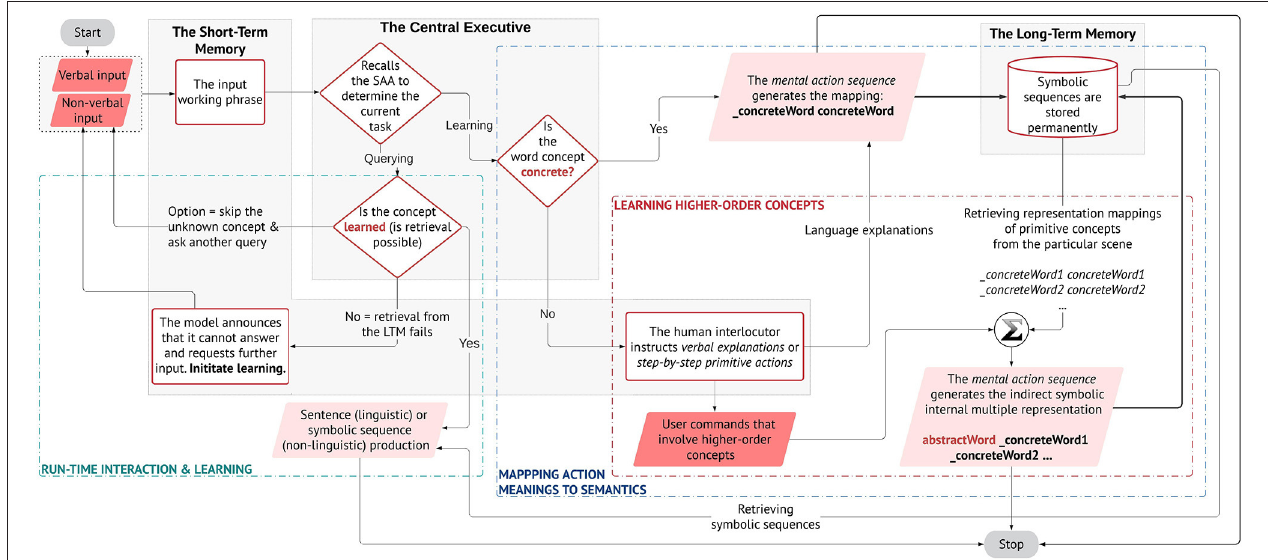
FIGURE 3 | The proposed learning methodology of meanings and language constructions. The central executive (CE), the long-term memory (LTM), and the short-term memory (STM) of the architecture are shown. The CE handles the decision-dependent processes, but not in a conventional if-else logic; rather, decisions are made based on the state-action association that is learned, memorised, and rewarded during the initial training. As a result, it can disambiguate the type of task that is handled by the STM and call the respective mental action sequence. The STM elaborates the working phrases through the mental actions. The LTM stores the symbolic sequences and is accessed during phrase retrieval to produce a valid output. The parallelograms represent either the user’s input (dark) or the system’s output (light). The output can be a spoken sentence or a symbolic phrase (actions to be executed by the robot). The interlocutor decides preferentially at run-time to teach a new concept (object/action) or to query the model (e.g., to learn an object or to perform an